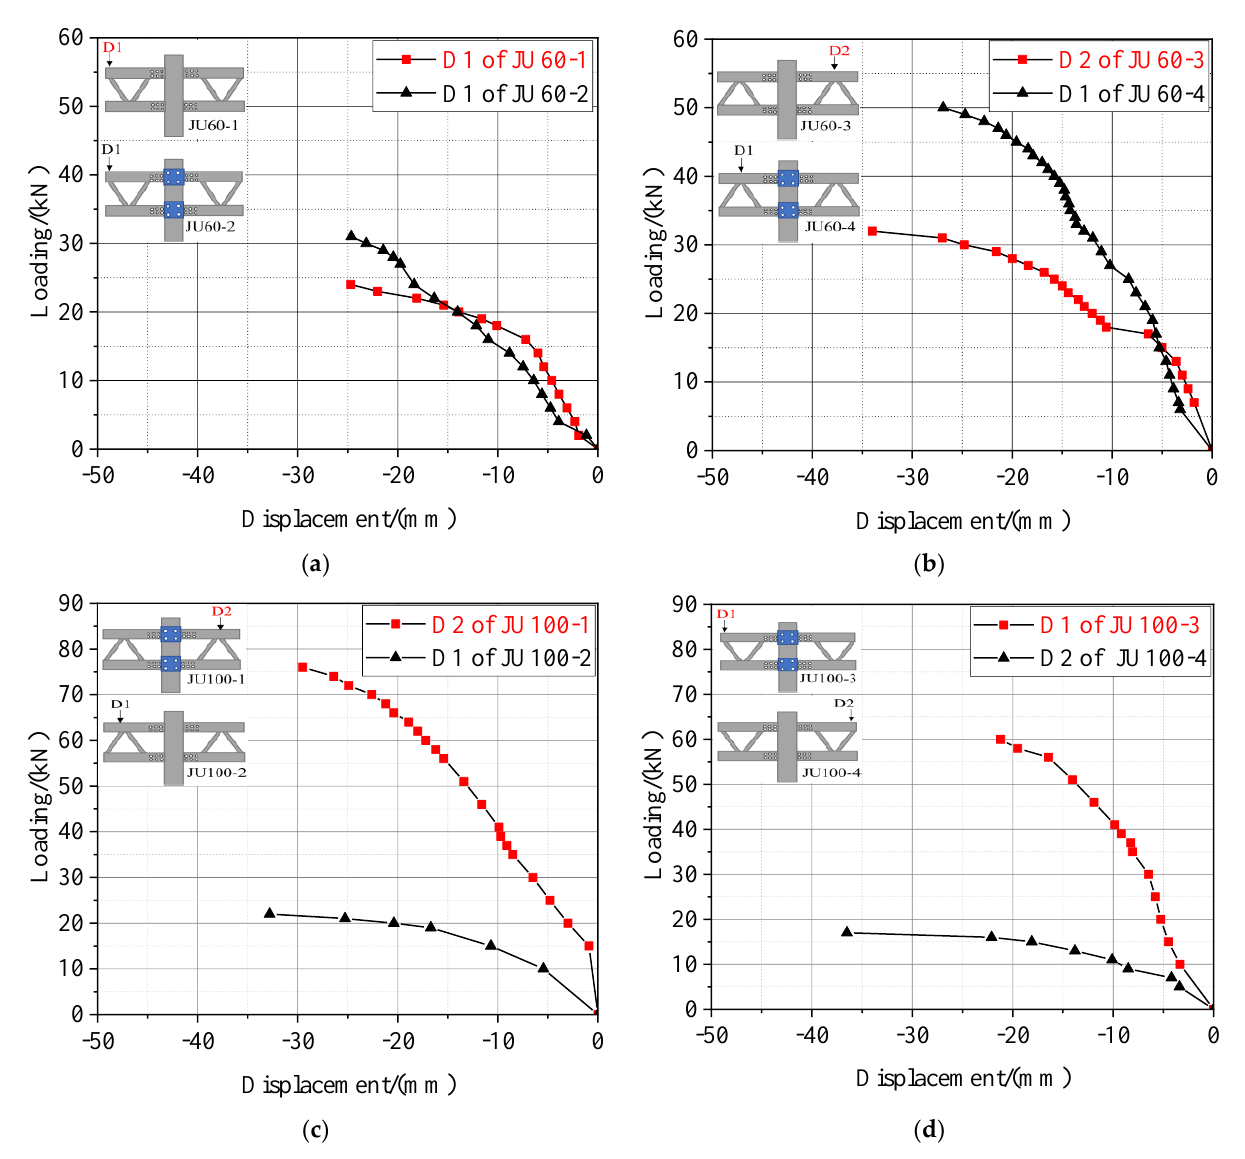
Figure 14. Effect of the column sleeve tube on the proposed beam − column connection. ( a ) JU60 − 1 and JU60 − 2, ( b ) JU60 − 3 and JU60 − 4, ( c ) JU100 − 1 and JU100 − 2, ( d ) JU100 − 3 and JU100 − 4.